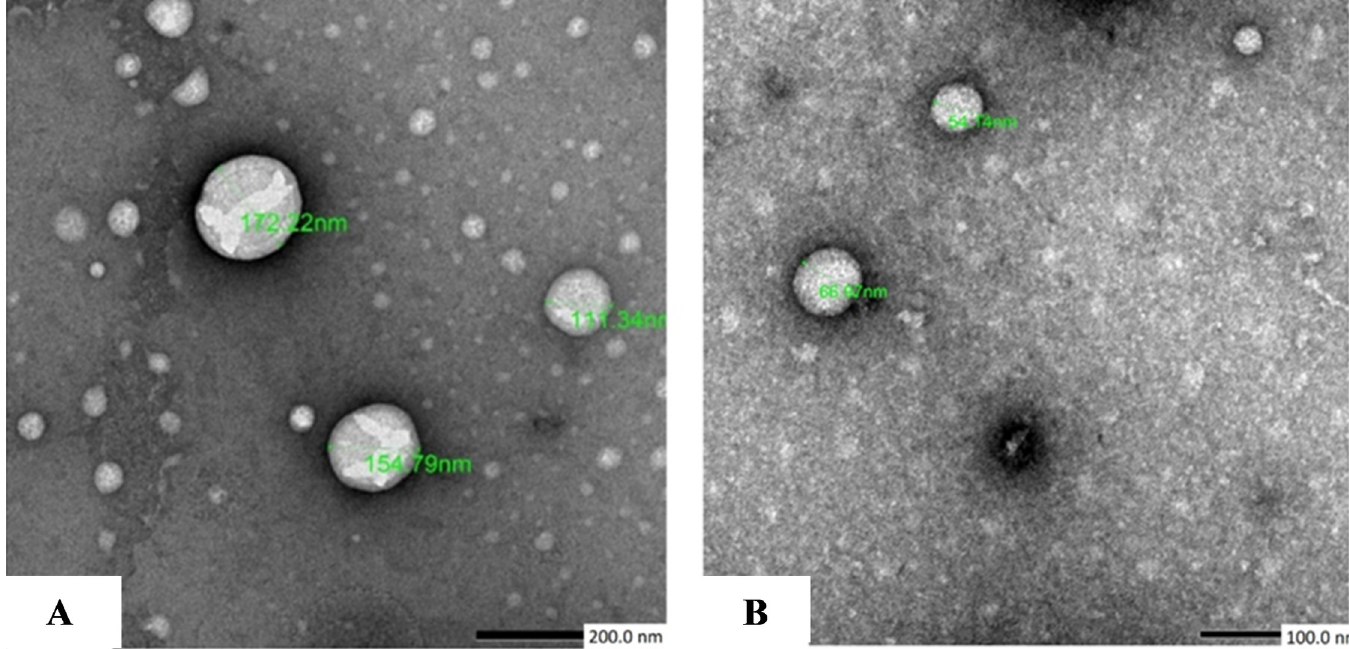
Fig 1. Transmission electron microscopic structure of the Schistosoma mansoni -egg derived extracellular vesicles (EVs) showing variable sized multiple EVs with regular rounded outline. (A: X 10000, B: X 15000).